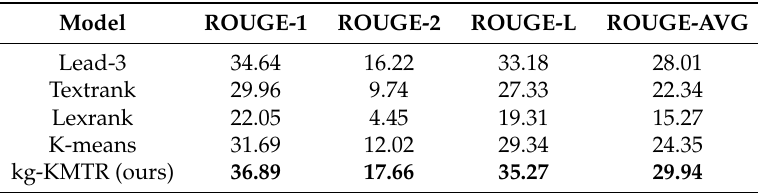
Table 2. ROUGE F1-score of unsupervised models on the test